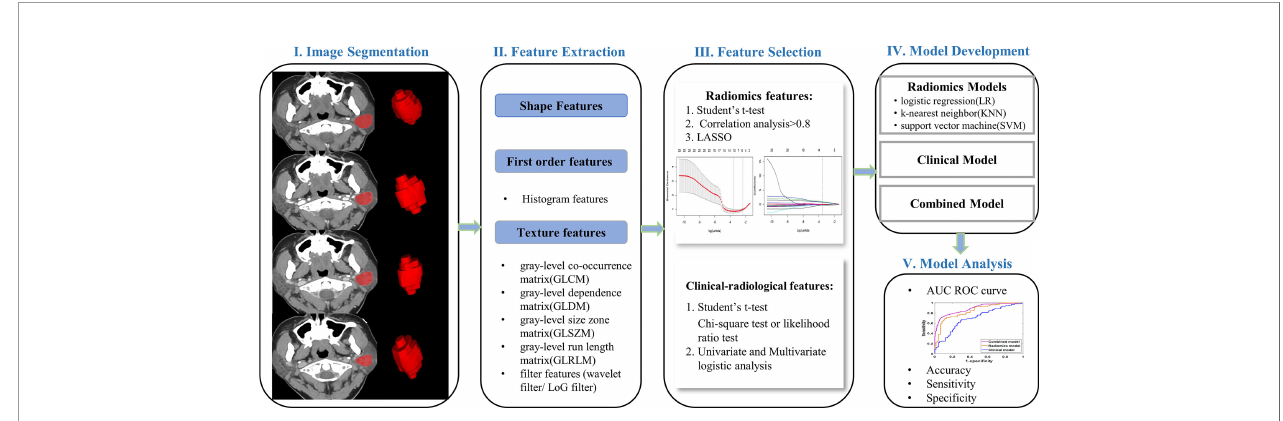
FIGURE 3 | Flowchart of the present research protocol.